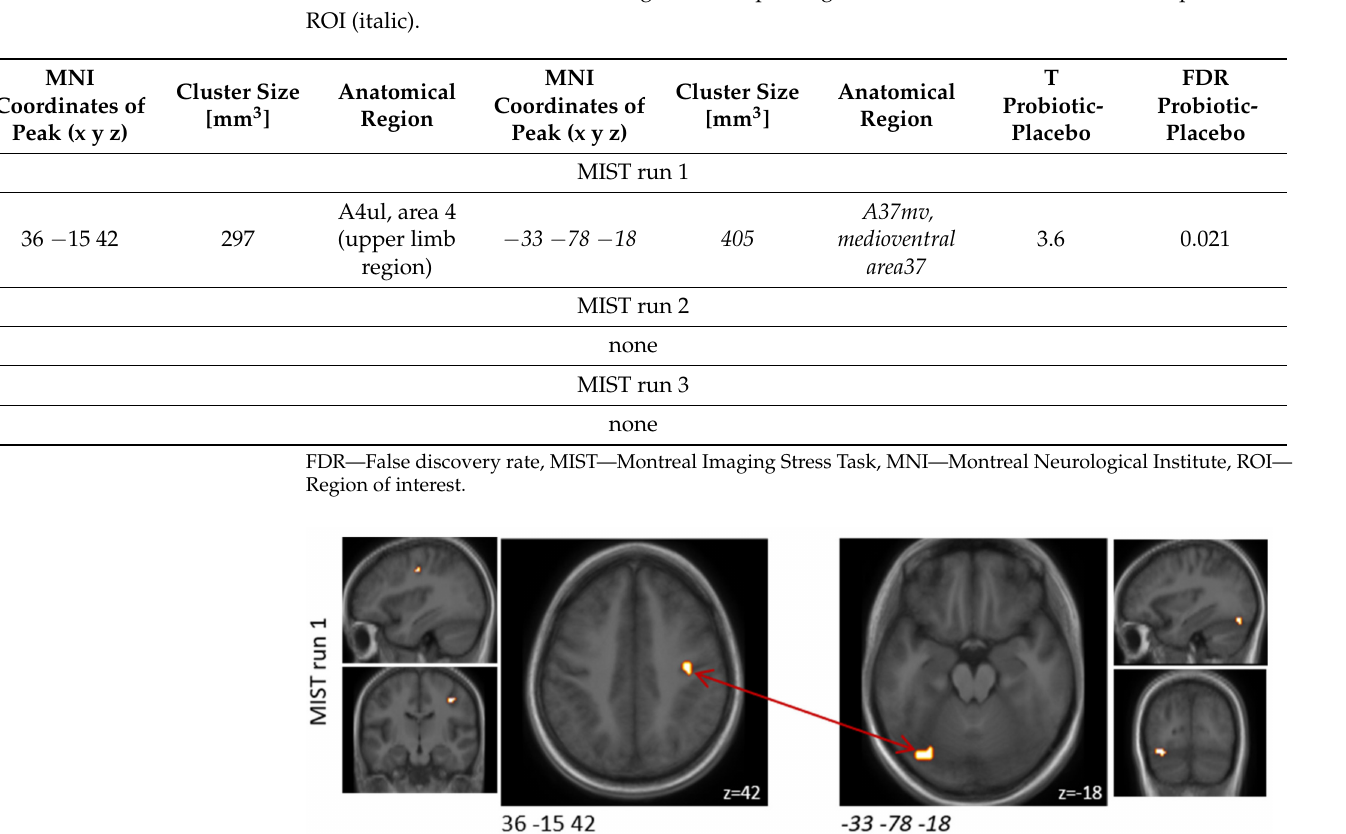
Figure 3. Schematic visualisation of clusters that were found to be associated with significant (FDR- corrected p < 0.05) functional connectivity changes when comparing the probiotic and the placebo interventions (probiotic > placebo) during the MIST paradigm. One of these clusters covered a predefined ROI (italic). Clusters are superimposed on average anatomical scans. Clusters can be identified by the coordinates of their peak (x y